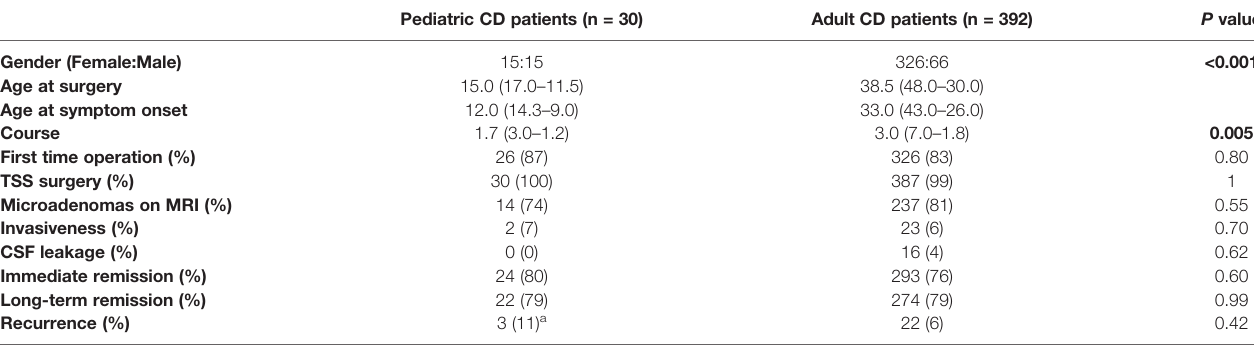
TABLE 1 | Basic information of pediatric and adult-onset CD.